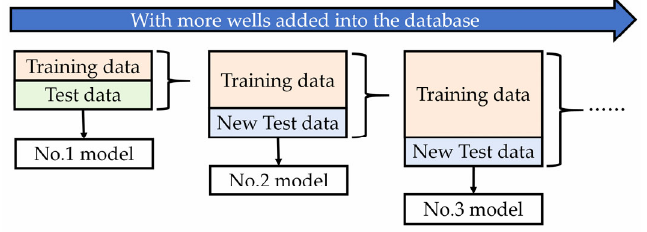
Figure 20. The diagram for continuous learning in production prediction.